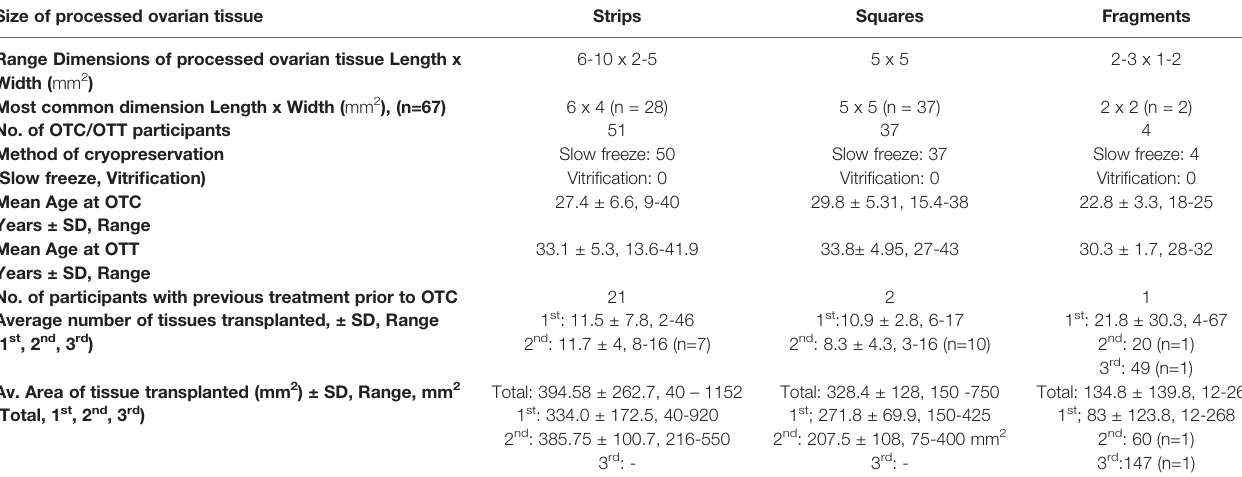
TABLE 3 | OTC/OTT Participant characteristics for fertility and hormone outcomes (21, 22, 25, 34, 37, 44, 57, 59, 61, 64, 66, 78, 84, 91 – 93, 95, 111, 115, 118, 124). Size of processed ovarian tissue Strips Squares